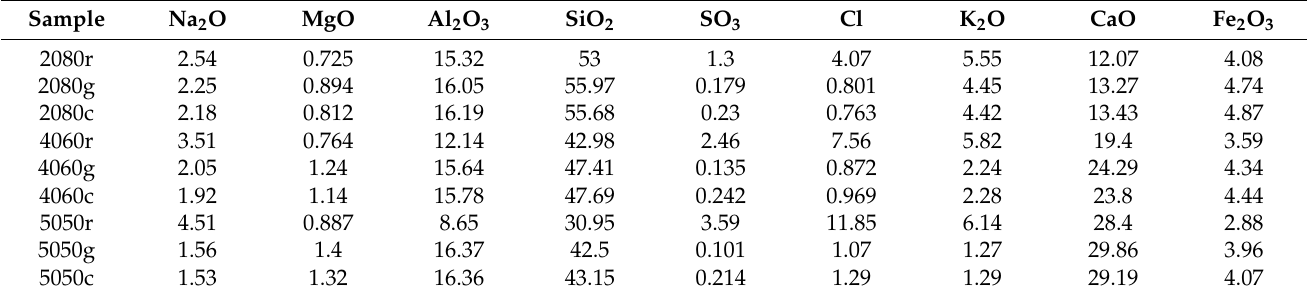
Table 6. Major chemical composition of raw materials and samples determined by XRF